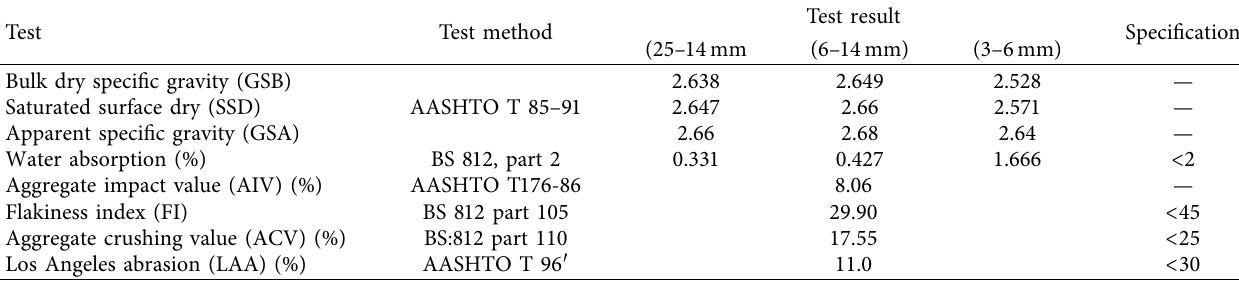
Figure 2: XRD pattern of Belessa kaolin. Table 3: Physical properties of aggregate.